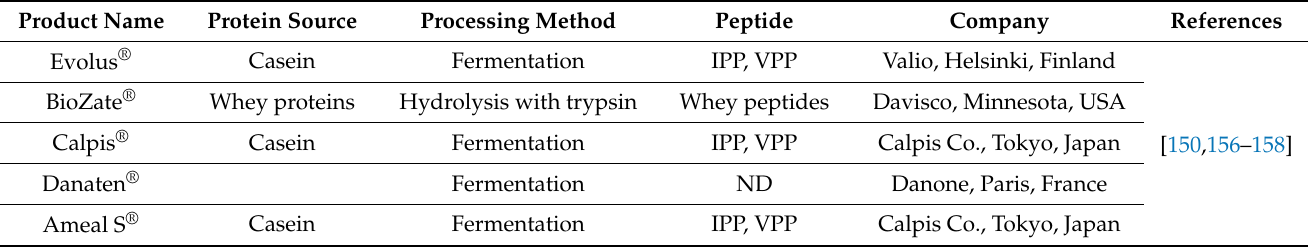
Table 6. Dairy products that contain peptides have the potential to reduce